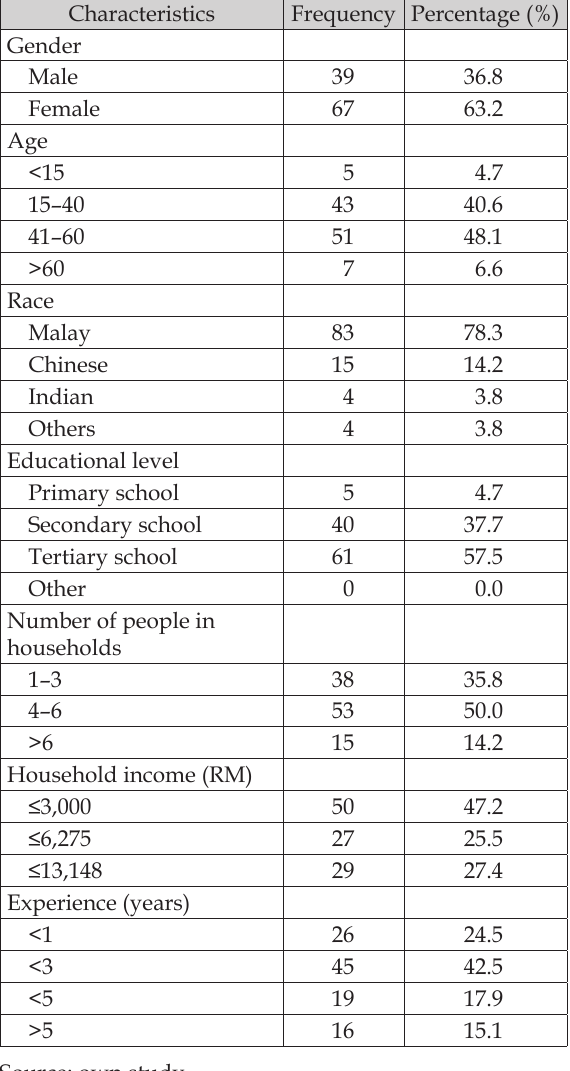
Table 1. Socio-demographic profile of respondents.